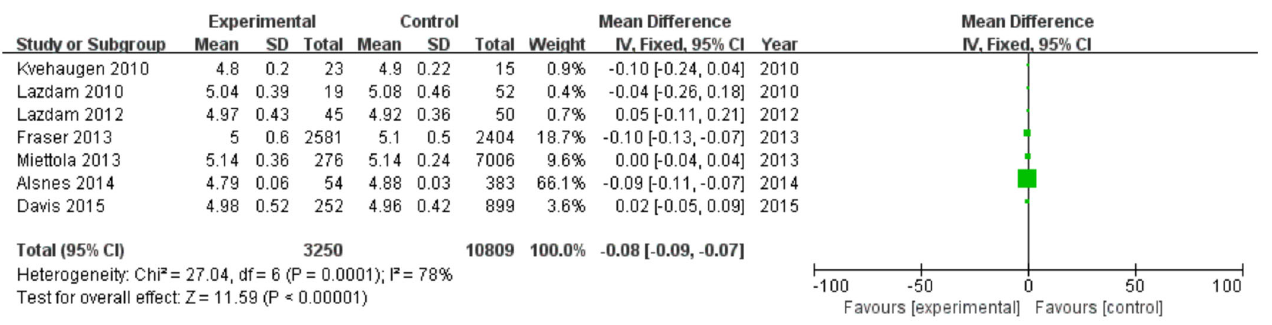
Figure 9. Meta ‐ analysis forest map for glucose of offspring of PE pregnancies. Kvehaugen 2010, [16];